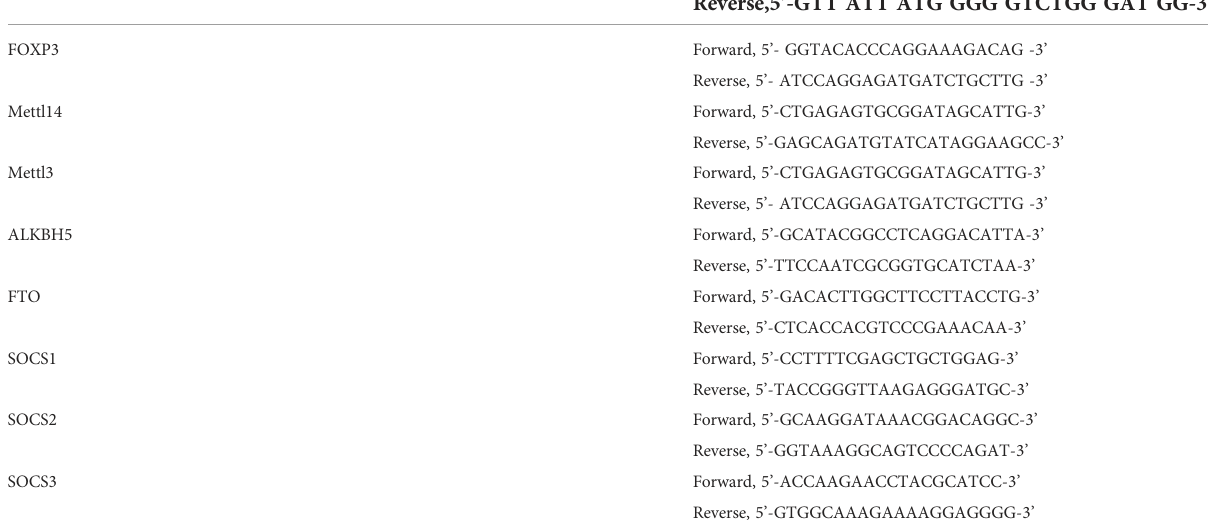
TABLE 1 The primer sets for RT-qPCR are shown below.